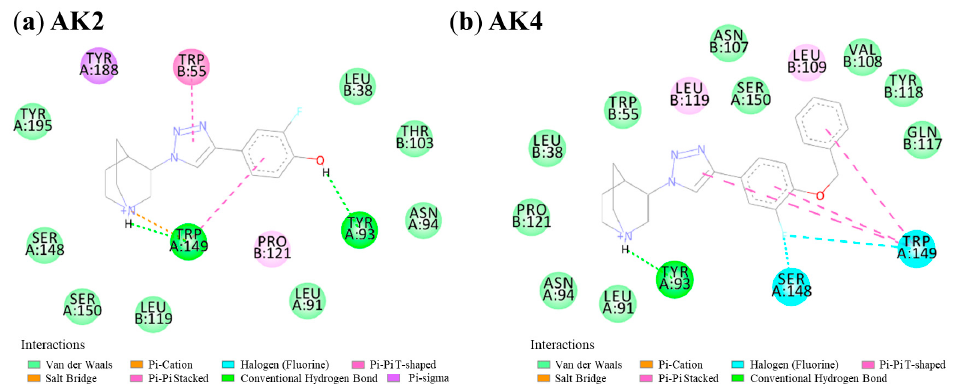
Figure 6. The binding modes of AK3 to ( a ) α 3 β 4 nAChR and ( b ) α 7 nAChR from MD simulation compared to molecular docking. A and B indicate principal and complementary subunits, respec- tively. Red circles indicate different interacting amino acid residues between MD simulation and molecular docking.